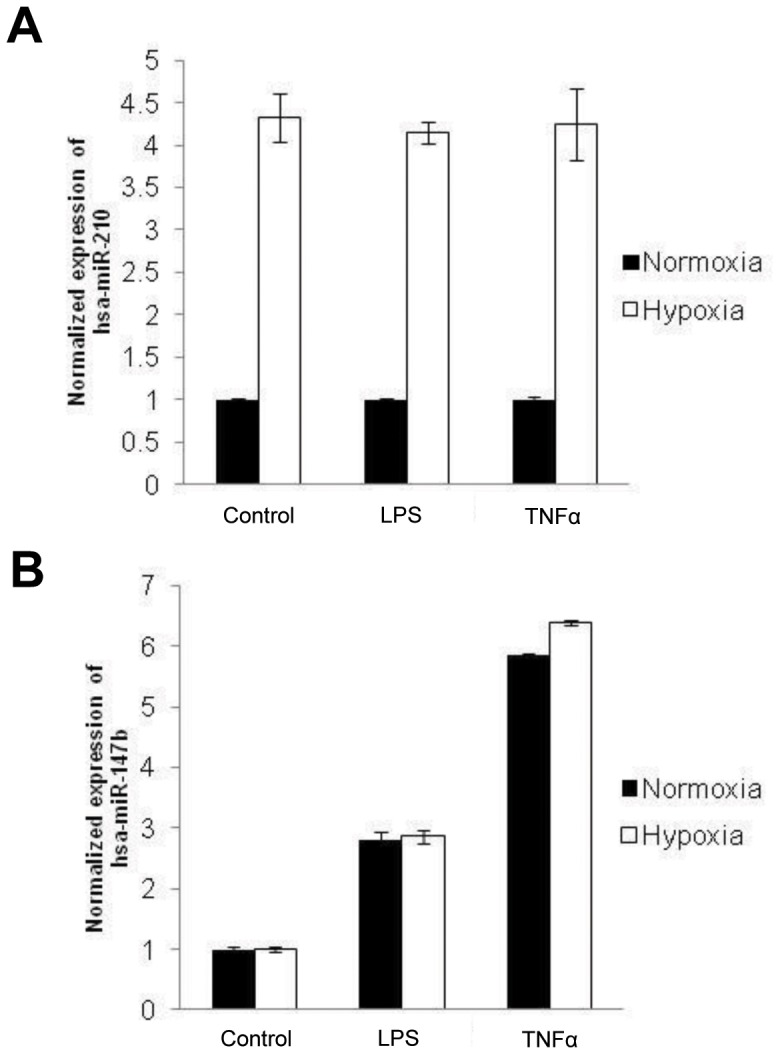
miR-147b and miR-210 expression in response to LPS, TNFα and hypoxia.MiR-210 (A) and miR-147b (B) expression was monitored by qPCR on RNA from A549 cells stimulated with 10 µg/ml LPS or 10 ng/ml TNFα with or without exposure to 1% O2 for 48 hours. Mean ± SEM is representative of 3 independent experiments carried out in triplicate.